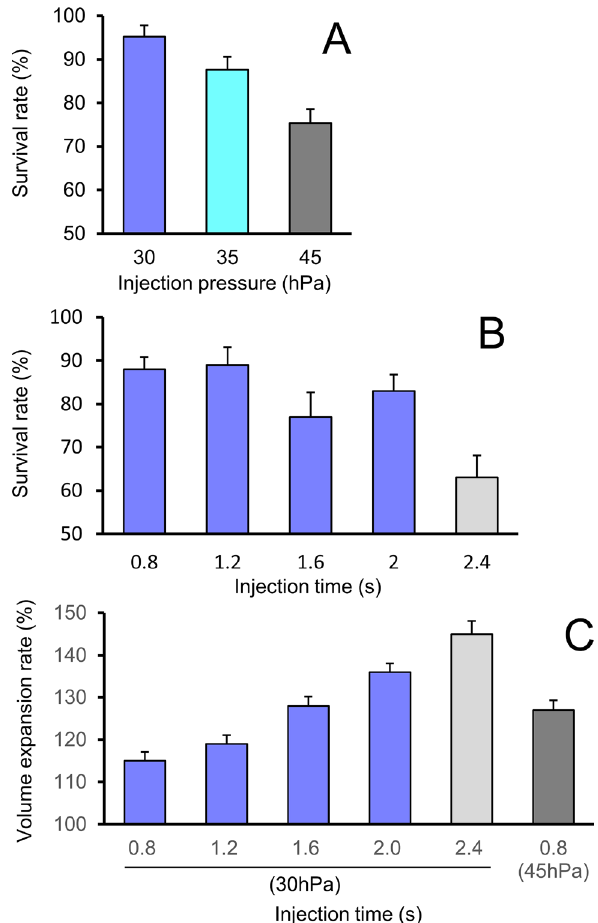
Figure 5. Injection pressure and injection duration influence the zygote survival rate and expansion rate. ( A ) The infusion time was fixed at 0.8 s and zygote survival was examined at infusion pressures of 30, 35, and 45 hPa. ( B ) With a constant pressure of 30 hPa, zygote survival was examined at injection times of 0.8, 1.2, 1.6, 2.0, and 2.4 s. ( C ) The pronuclear volume expansion rate when injected at the indicated